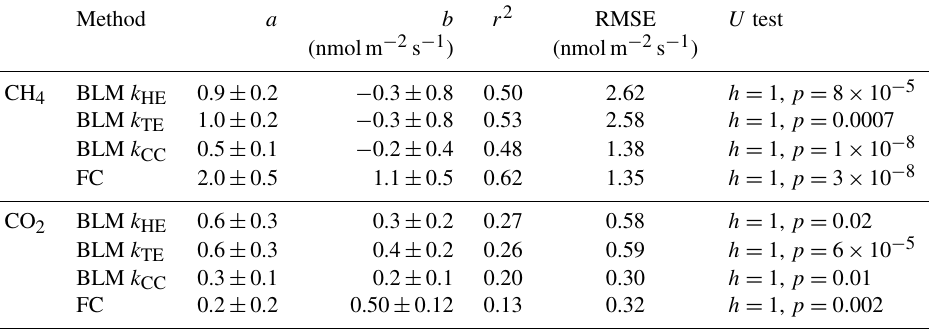
Table 2. Linear fit y = ax + b parameters for comparison between EC and BLM fluxes according to different models for k , and between EC and FC, when EC flux estimates were on the x axis. Uncertainties are given by the standard errors of the parameters. The last column gives the results of Mann–Whitney U test for each method compared with EC. The comparison was made using daily median